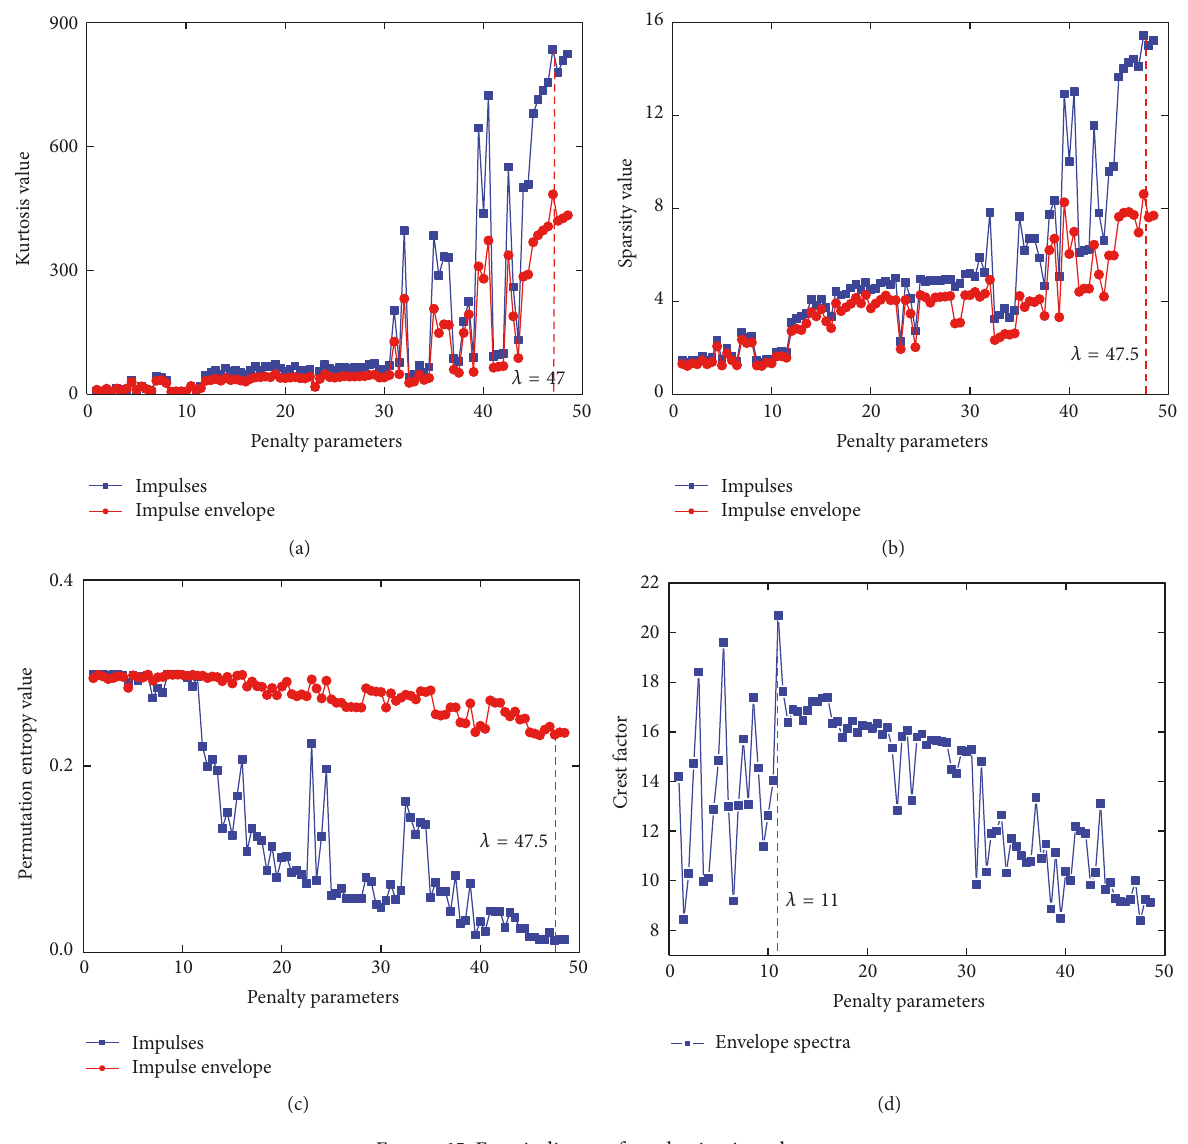
Figure 15: Four indicators for selecting